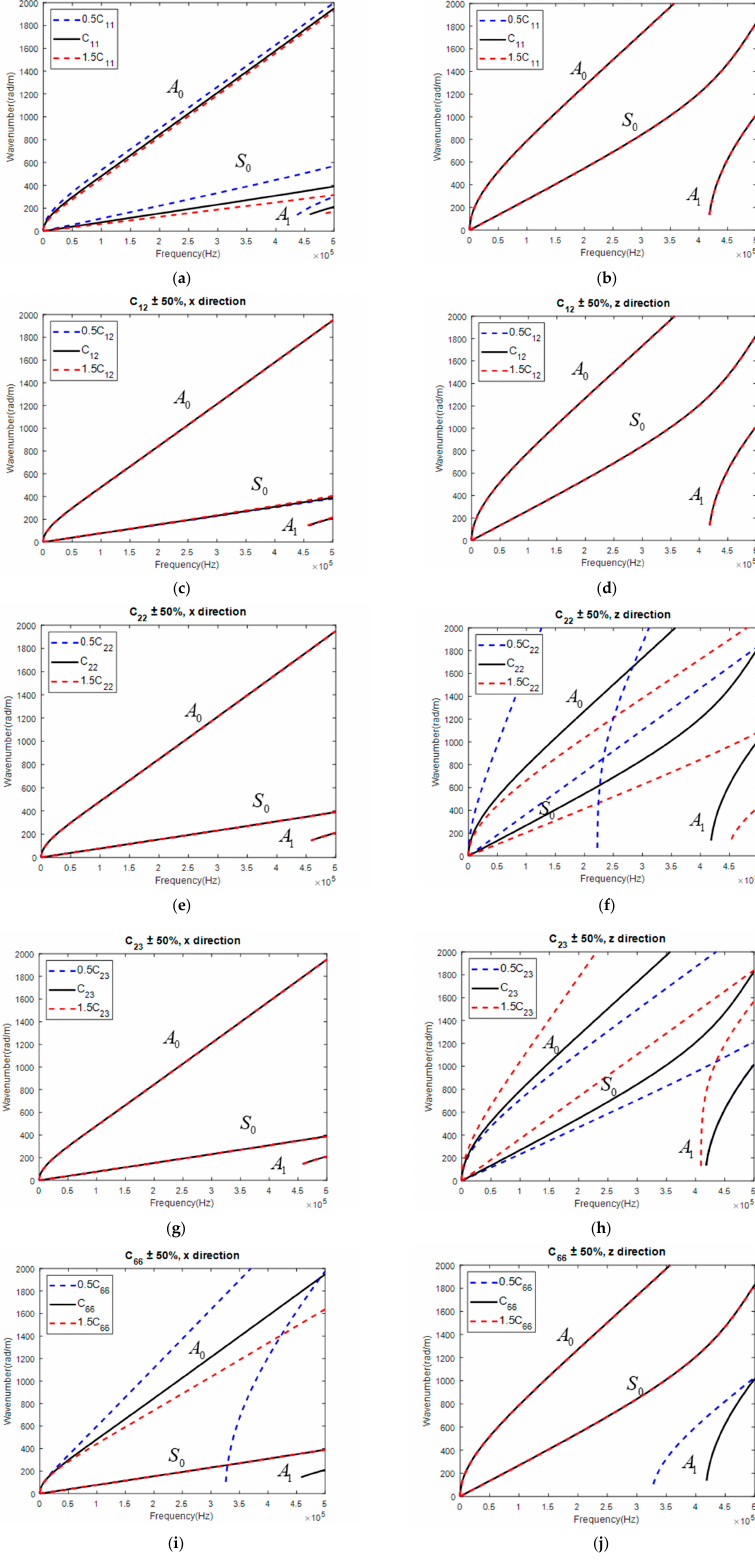
Figure 6. Influence of parameter on GW dispersion curve in UD: 𝐶 (cid:2869)(cid:2869) on GW along ( a ) 𝑥 and ( b ) 𝑧 direction; 𝐶 (cid:2869)(cid:2870) on GW along ( c ) 𝑥 , and ( d ) 𝑧 direction; 𝐶 (cid:2870)(cid:2870) on GW along ( e ) 𝑥 and ( f ) 𝑧 direction; 𝐶 (cid:2870)(cid:2871) on GW along ( g ) 𝑥 and ( h ) 𝑧 direction; 𝐶 (cid:2874)(cid:2874) on GW along ( i ) 𝑥 and ( j ) 𝑧 direction. Taking the CP and QI for further investigation, the corresponding GW dispersion curves are displayed in Figures 7 and 8, respectively. It was concluded that 𝐶 (cid:2869)(cid:2870) was still insensitive to GW along both directions, which made it hard to be correctly identified. Except for that, other parameters showed the potential of being correctly reconstructed, as the change of parameters all influenced the dispersion curve of the GW in both direc- tions. Thus, all five independent parameters were simultaneously reconstructed with a GW along both directions.